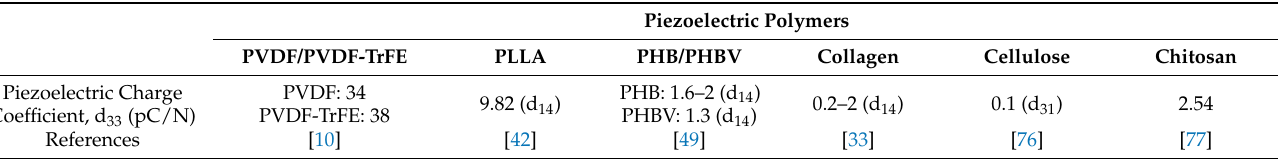
Figure 3. Chemical structures of the main piezoelectric polymers used for TE applications. Table 4. Piezoelectric charge coefficient of main piezoelectric polymers applied so far in piezoelectric scaffold ‐ based OCTE strategies.